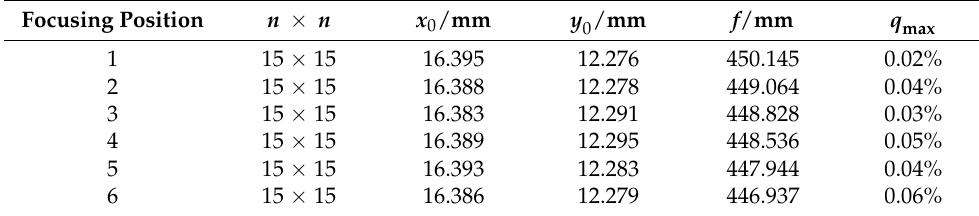
Table 7. The calibration results of the interior orientation elements.